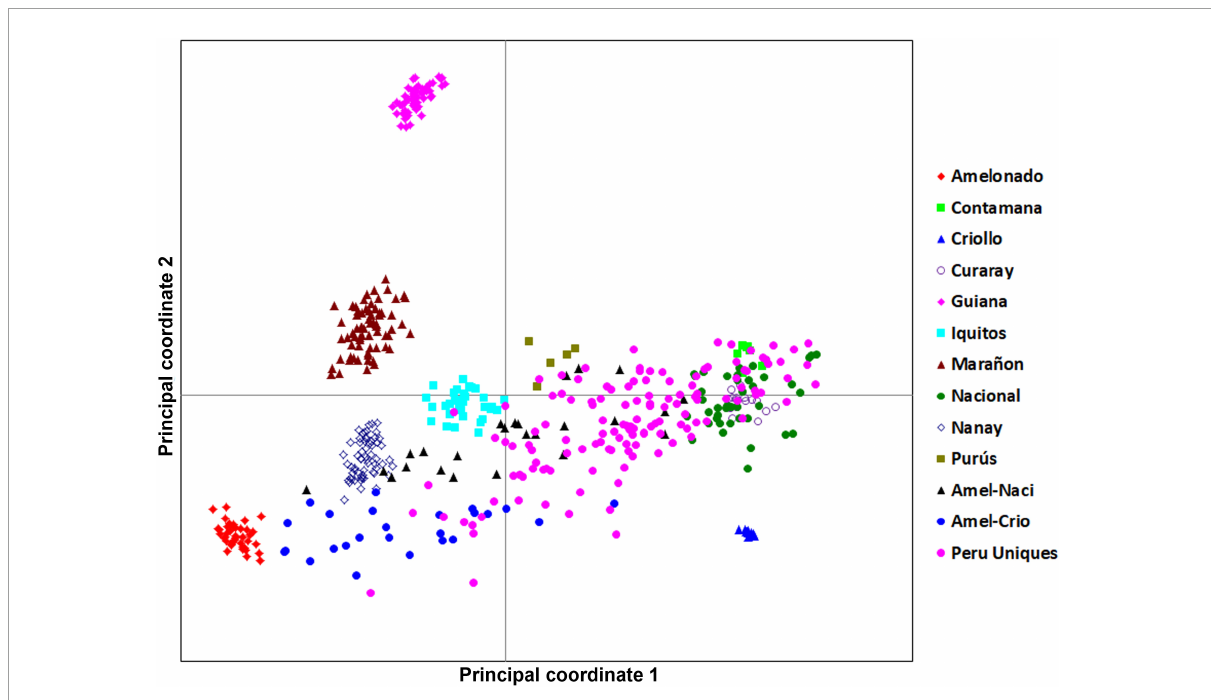
FIGURE2 A principal coordinate analysis 2D-scatter plot of 134 Peru Uniques and 390 reference accessions using 170 SNP genetic data. The first and second axes explained 23.86 and 10.80% of the variation, respectively.